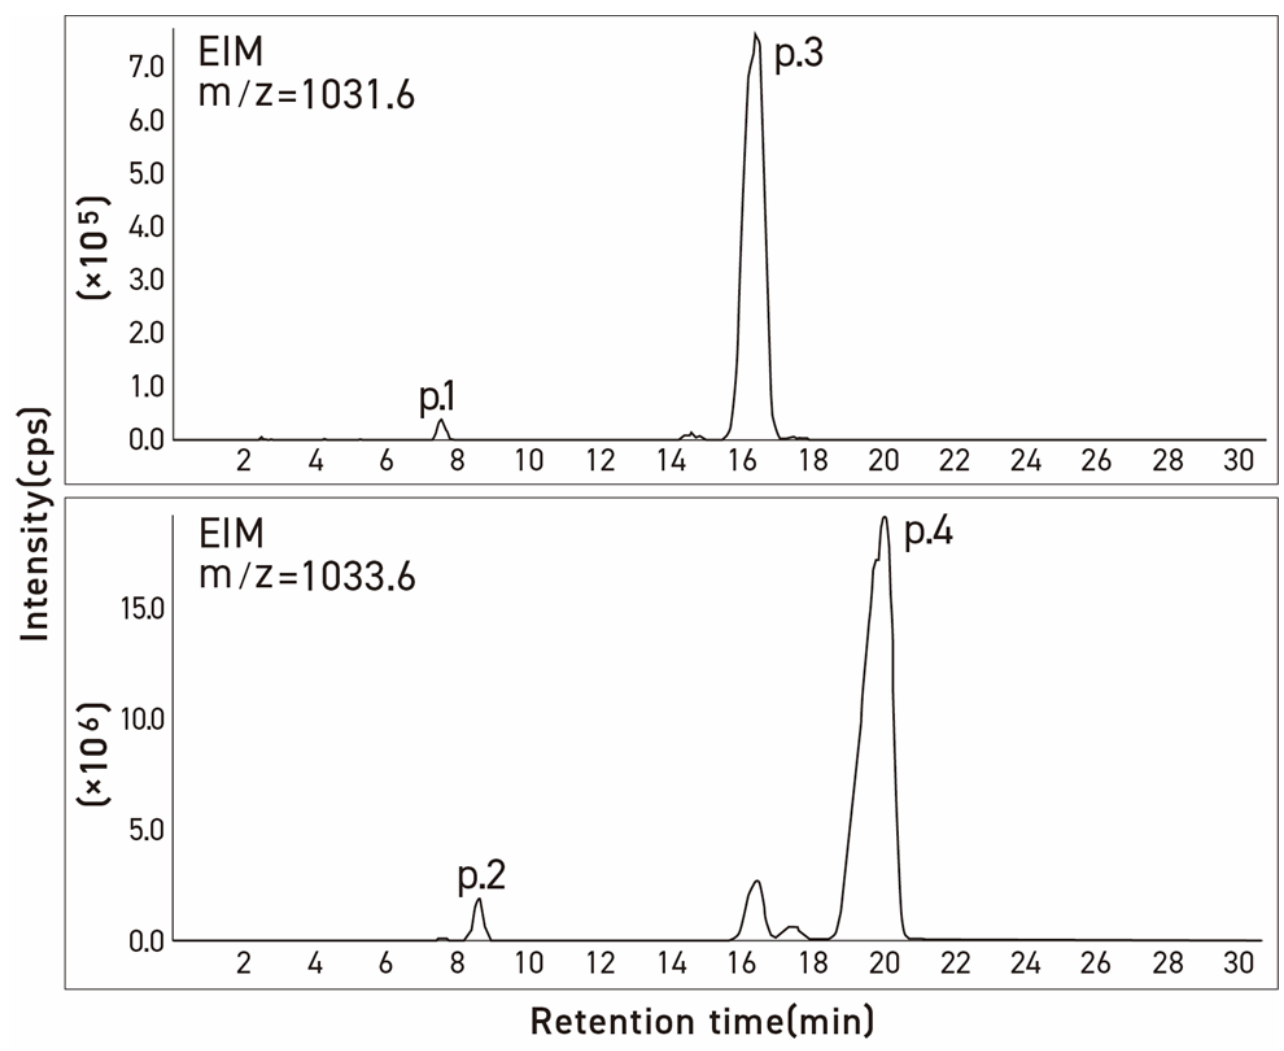
Figure 4. Ion mass chromatograms of commercial α-tomatine determined by LC-MS. Condition: column, Inertsil ODS-3v [5 μm, 4.0 mm × 250 mm]; column temp, 20 °C; injection volume, 20 μL; mobile phase, acetonitrile/20 mM ammonium acetate in water (35:65, v / v ); flow rate, 0.8 mL/min.